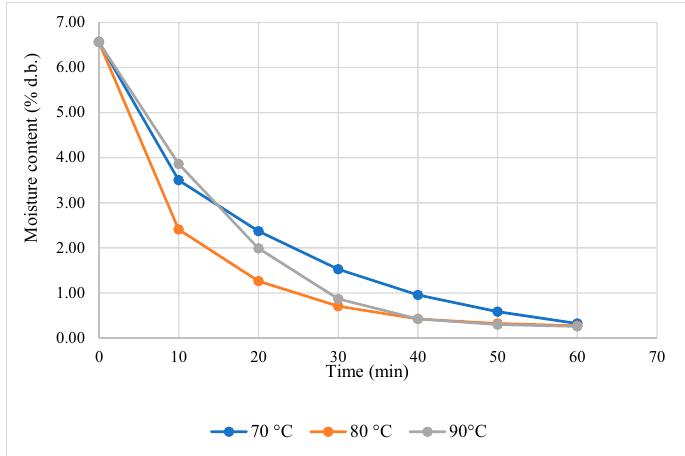
Figure 1. Drying curves of hot air dryers at 70, 80 and 90 °C. Drying experiments of mango slices in greenhouse dryers were carried out on 26 June 2021. Drying curves and drying rates of mango slices using greenhouse solar dryers are shown in Figures 2 and 3. Regarding the variation of measured moisture content (dry basis) of mango slices each time of drying, it could be observed that the moisture content reduced from 8.68% to 0.14% within 1 day when using greenhouse solar dryers. The drying rate in greenhouse solar dryers increased sharply when the moisture fell below 6.95%. The shape of the drying curve indicates a rapid moisture content removal from the product at the initial stage, which later decreased with the increase in drying time. Thus, the moisture ratio decreased continually with the drying time [7,8].